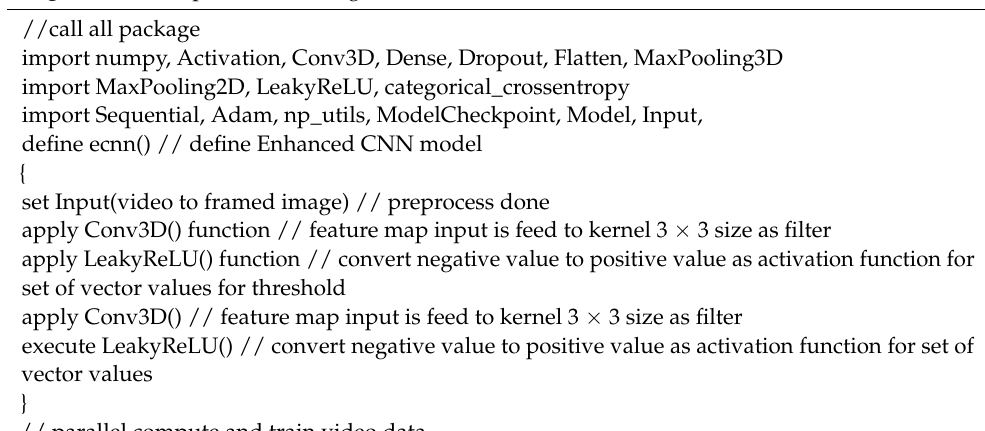
Algorithm 1: Proposed ECNN